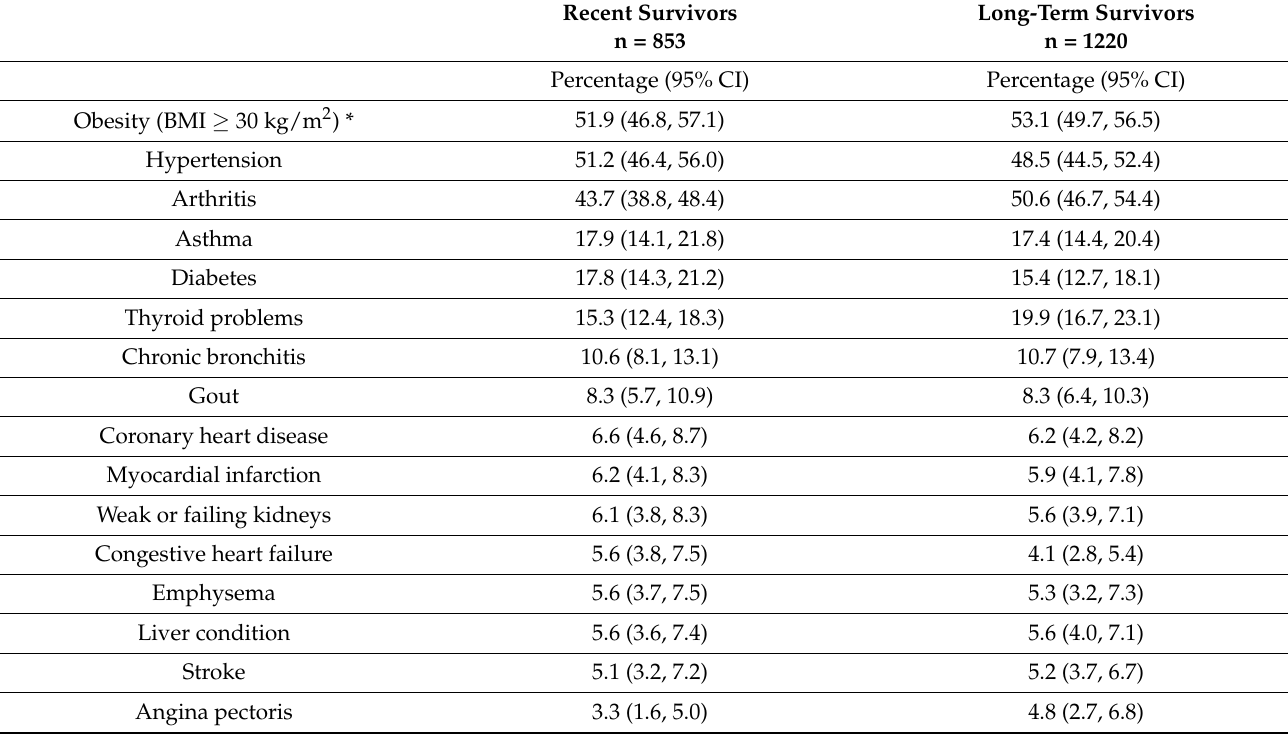
Table A2. Prevalence of different comorbidities in recent and long-term cancer